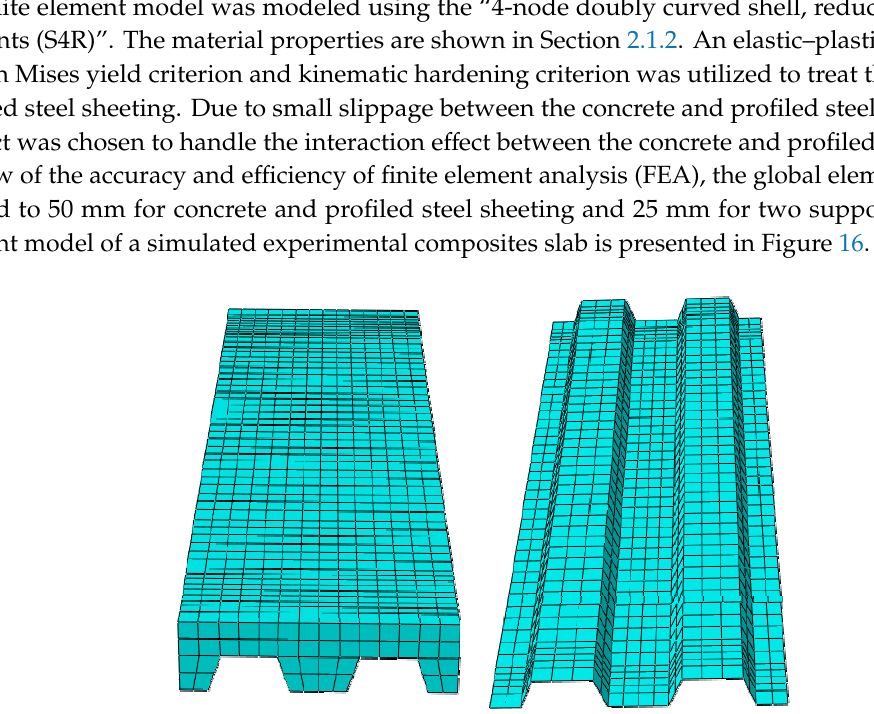
Figure 15. Typical final end slip between concrete and profiled steel sheeting (for an SCLC-B-2 slab).